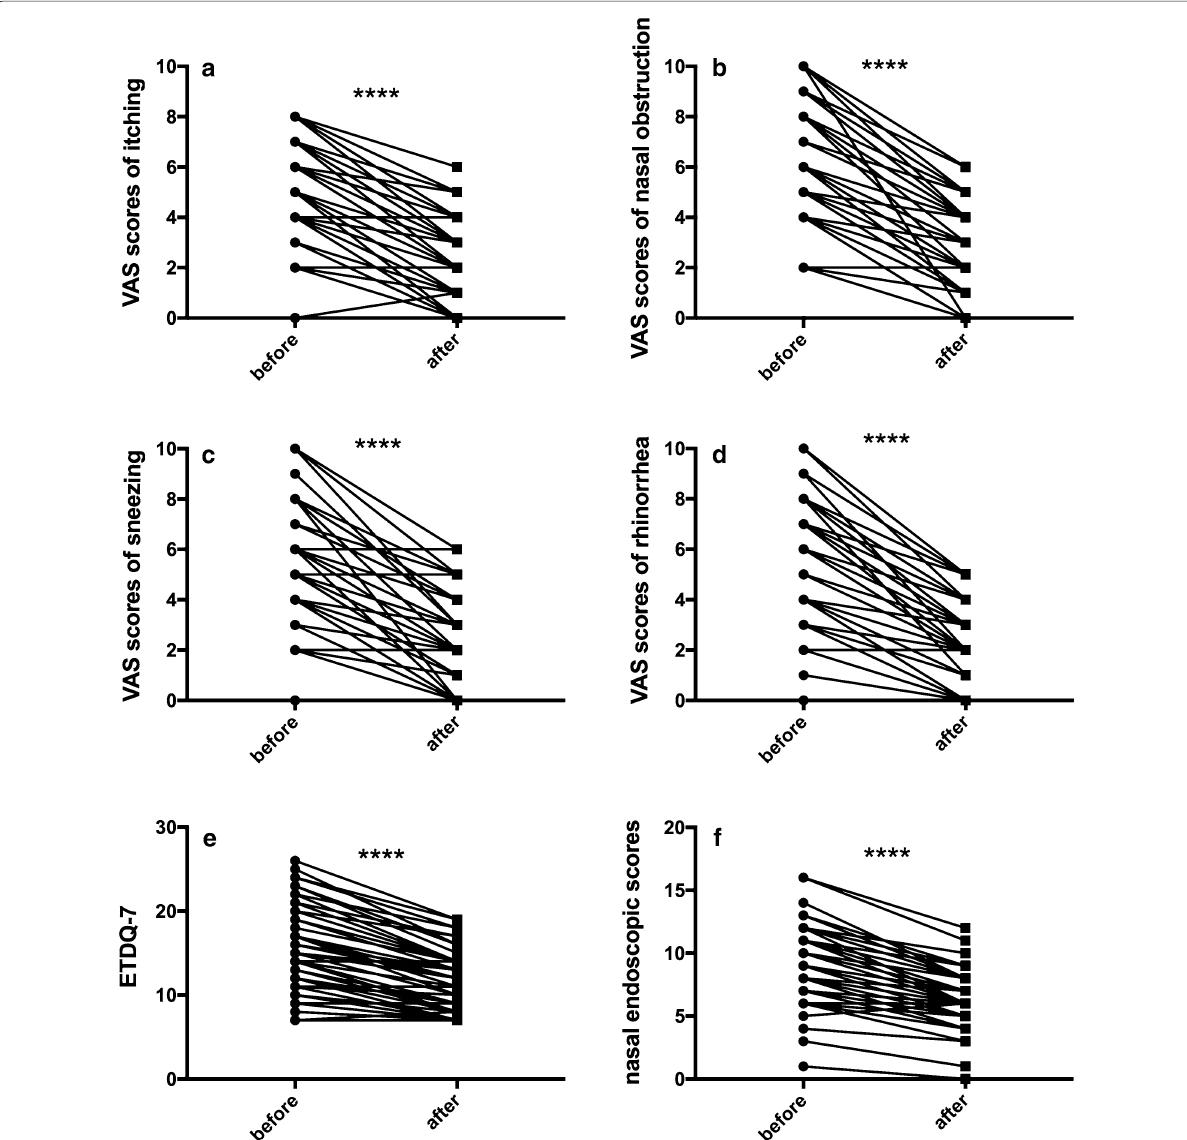
1.500 for itching, 2.373 1.790 for sneezing, ± ± 5.201 before treatment ± 3.088 before treatment to 6.186 2.381 after ± ±